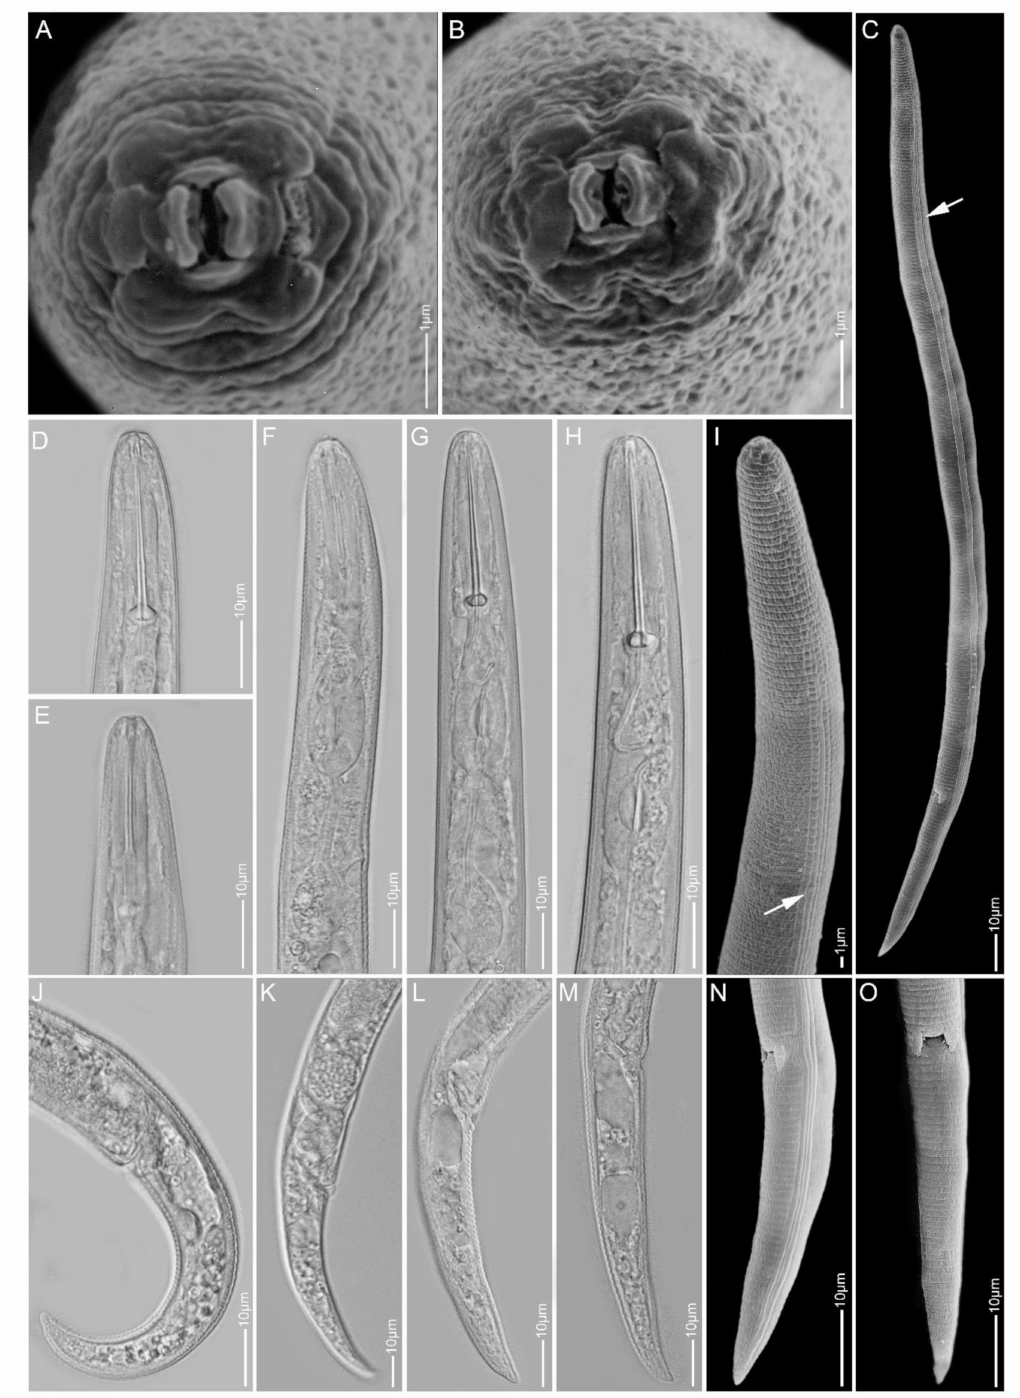
Figure 12. Light and scanning electron microscopy images of Paratylenchus sp.2 females: ( A , B ) face view; ( C ) total body; ( D – I ) anterior region; ( J – O ) tail region; arrows pointed at deirids in ( C , I ). 2.1.12. Paratylenchus sp.BE11 Females (Sample BE11; n = 3; Figure 13): Body about 0.3 mm long with maximum body width of about 15 µ m, heat relaxed specimens open C- to 6-shape. Lateral field with four lateral lines. Deirids not observed. Head broadly rounded, submedian lobes not protruded, cephalic sclerotization strong. Stylet about 15 µ m long, cone 60% of stylet length, knobs 3 µ m across. Pharynx about one-fourth of body length. Secretory-excretory pore at